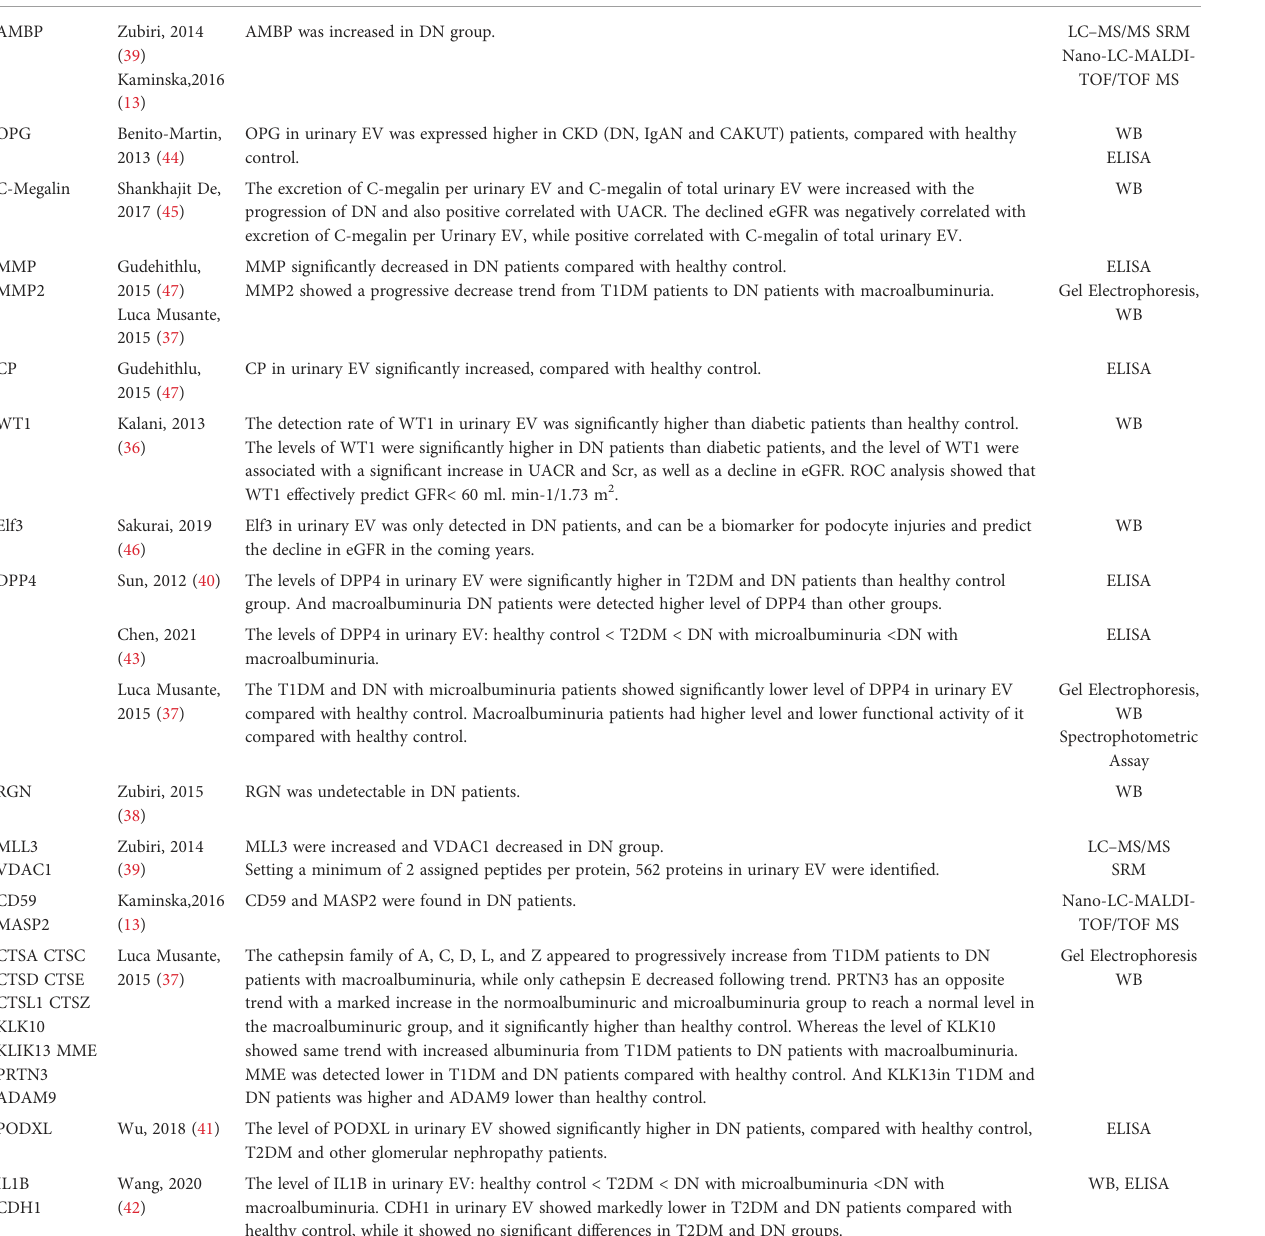
TABLE 4 The results of potential biomarkers of DN in 13 eligible